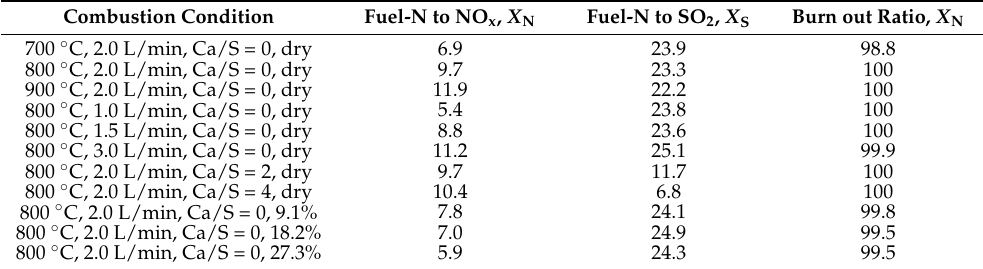
Table 5. Conversion ratio of fuel-N (fuel-S) to NO x (SO 2 ) and C burnout ratio under different experimental